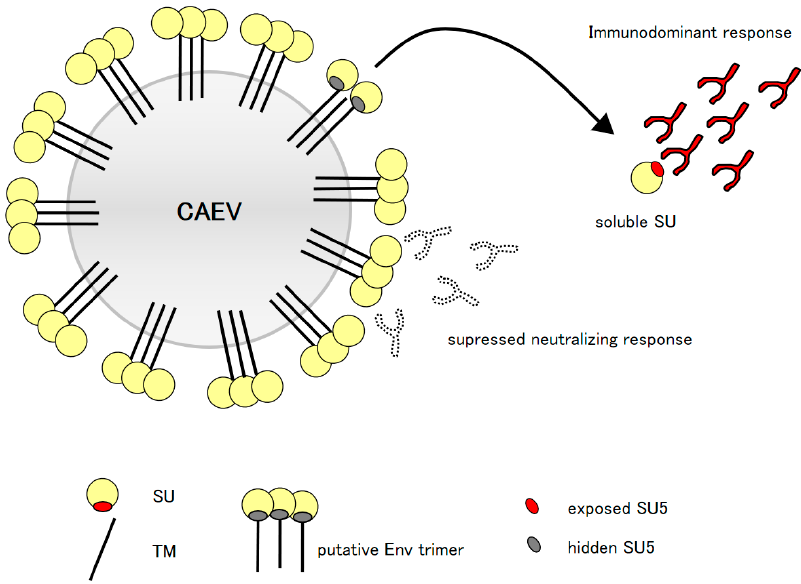
Figure 4. Model of the proposed “original antigenic sin”: Virus infected cells and virus particles release in the environment soluble forms of SU, unmasking the highly immunogenic SU5 region (red oval), which is normally hidden in the functional conformation of Env (gray oval). The released particles attract a strong, immunodominant, high avidity and polyclonal anti-SU5 antibody response that dominate the clonal hierarchy of the B cell immune response (antibody with black lines and red fill), potentially interfering with an efficient neutralizing response (antibody with dotted lines and white fill).